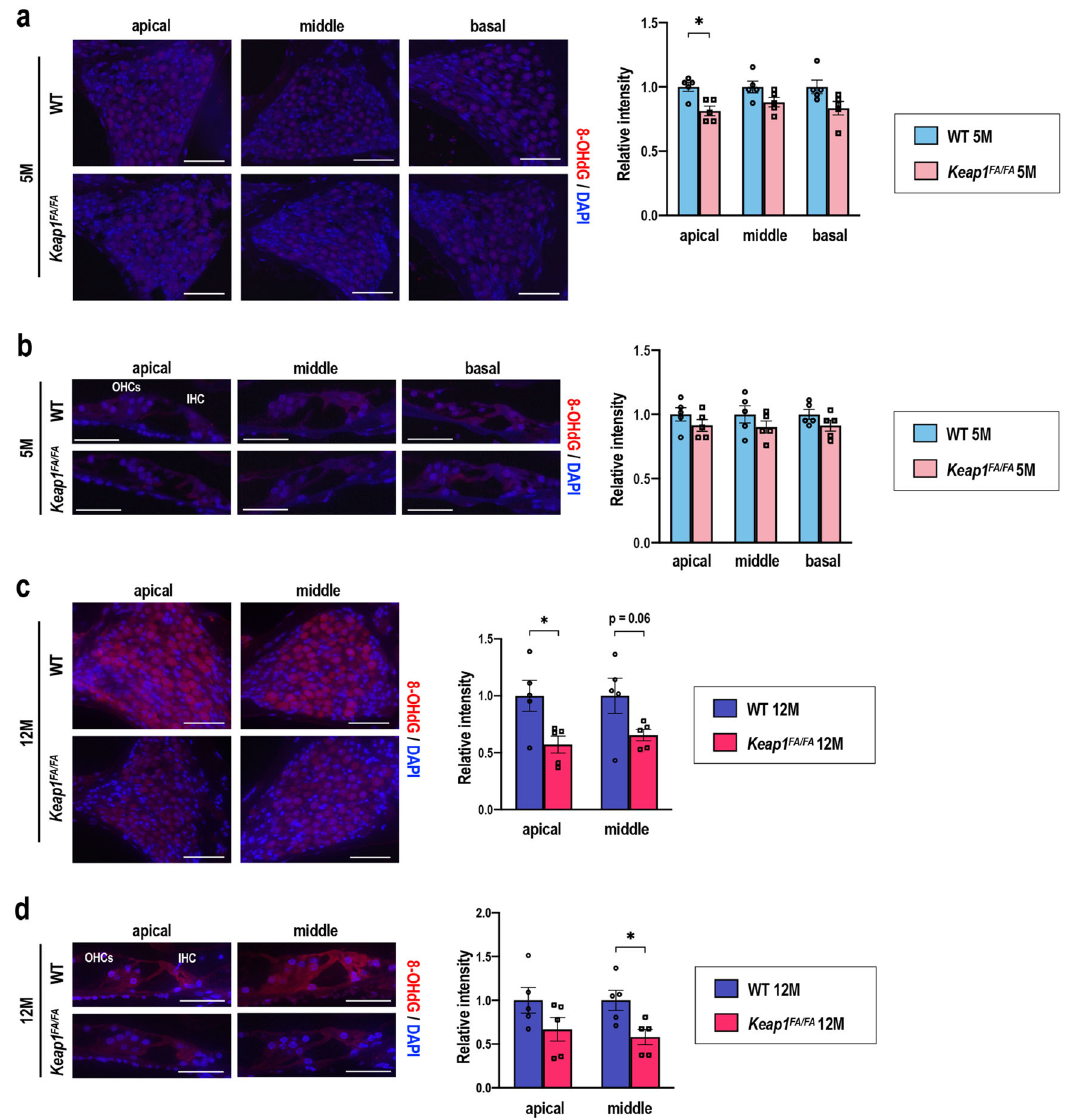
Fig. 12 Accumulation of 8-OHdG in the WT and Keap1 FA/FA cochleae at 5 and 12 months of age. Immuno fl uorescence detection of 8-OHdG in the SGNs ( a , c ) and hair cells ( b , d ) at each turn in the Keap1 FA/FA and WT mice at 5 ( a , b ) and 12 ( c , d ) months of age. 8-OHdG signals are shown as red fl uorescence. Nuclei were counterstained with DAPI (blue). OHCs, outer hair cells; IHC, inner hair cell. The experiments were performed for fi ve samples in each group. Relative intensities of the 8-OHdG signals at each turn were semi-quanti fi ed. Average staining intensities of WT mice are set as 1. The data represent the mean ± SEM. * P < 0.05. Unpaired two-tailed Student ’ s t -test was applied. Scale bars correspond to 50 μ m ( a , c ) and 20 μ m ( b , d